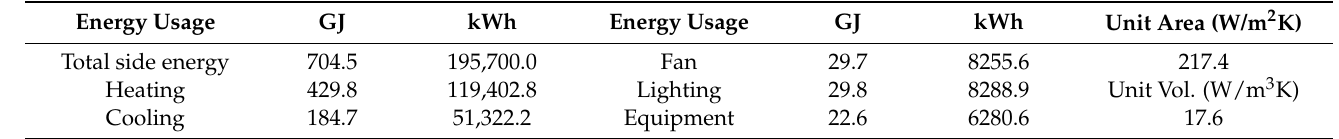
Table 8. The total energy consumption of the base mosque